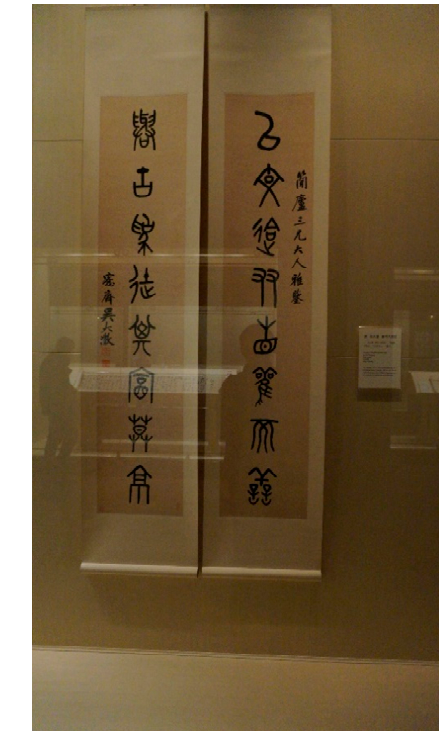
Figure 4. Dim exhibition hall.